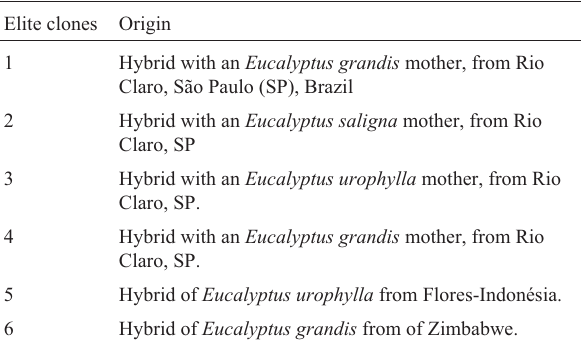
Table 1 - Relation of elite Eucalyptus clones used in the crossings with Eucalyptus globulus . Elite clones